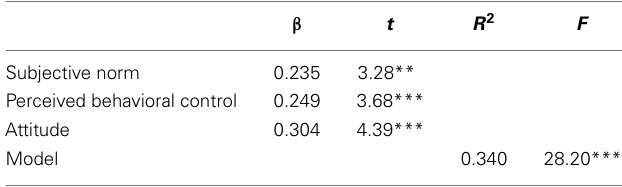
Table 2 | Regression results for theTPB variables to predict intentions to engage in energy-saving behavior ( N = 168); β , standardized regression coefficient; t , t -statistic; R 2 , total variance explained; F , F -statistic